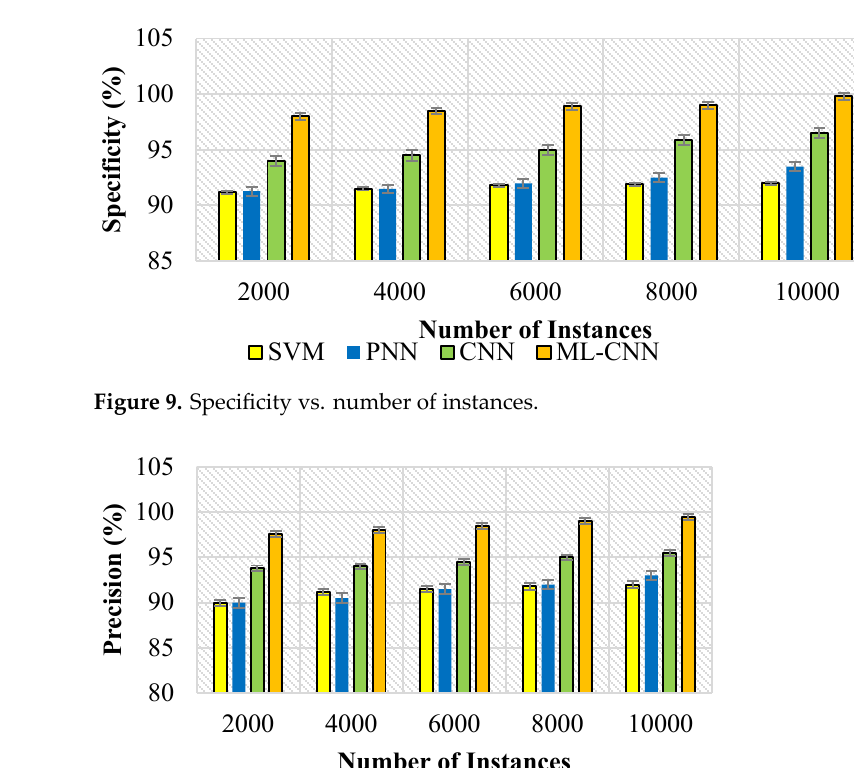
Figure 8. Sensitivity vs. number of instances .